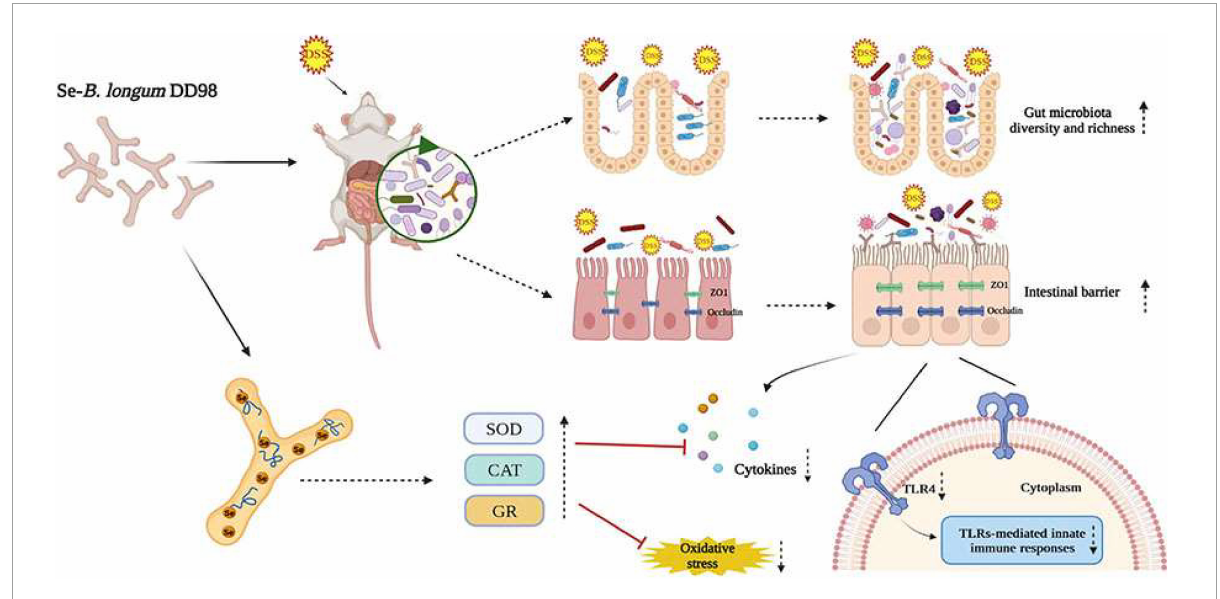
FIGURE8 Proposed mechanisms of Se- B . longum DD98 in the inhibition of DSS-induced colitis in mice.